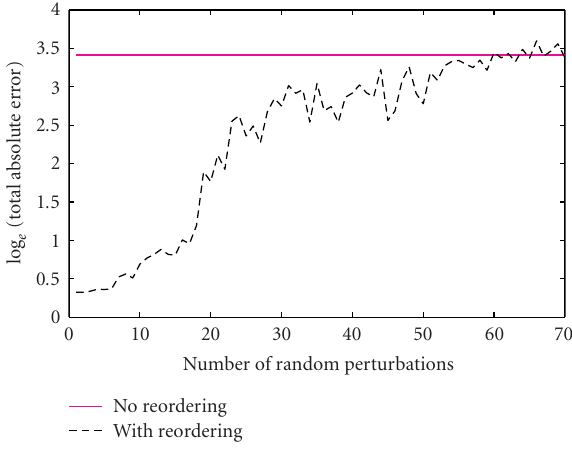
Figure 4: Comparison of errors in the reconstruction for the nonsmooth signal in Figure 1(b) without reordering and with reordering as a function of inaccuracies in the